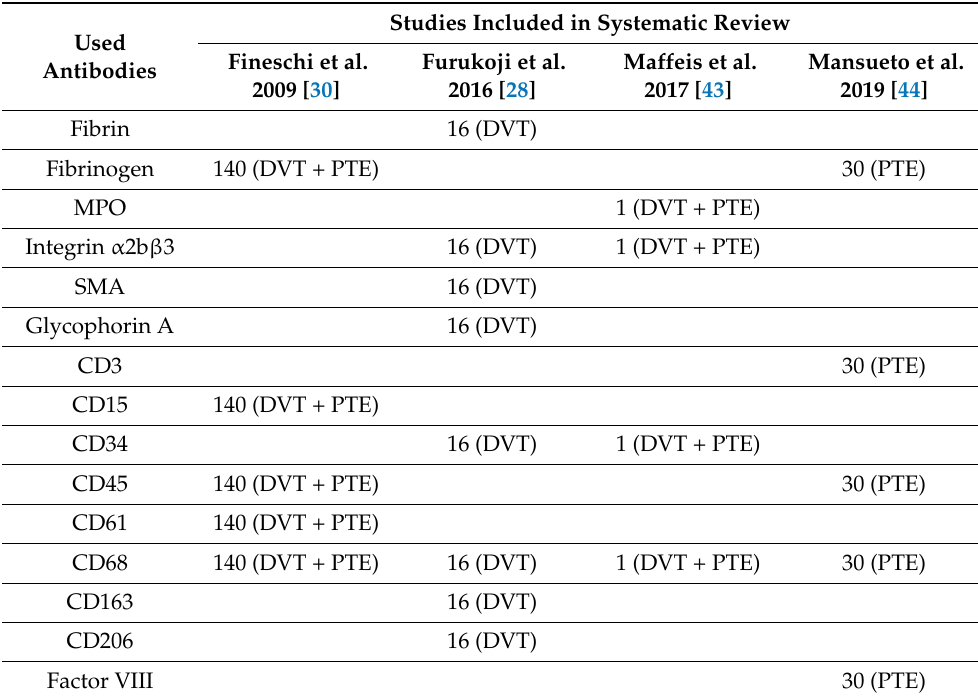
Table 1. Summary of antibodies used in the studies considered and type and number of samples. Studies Included in Systematic Review Used Fineschi et Antibodies